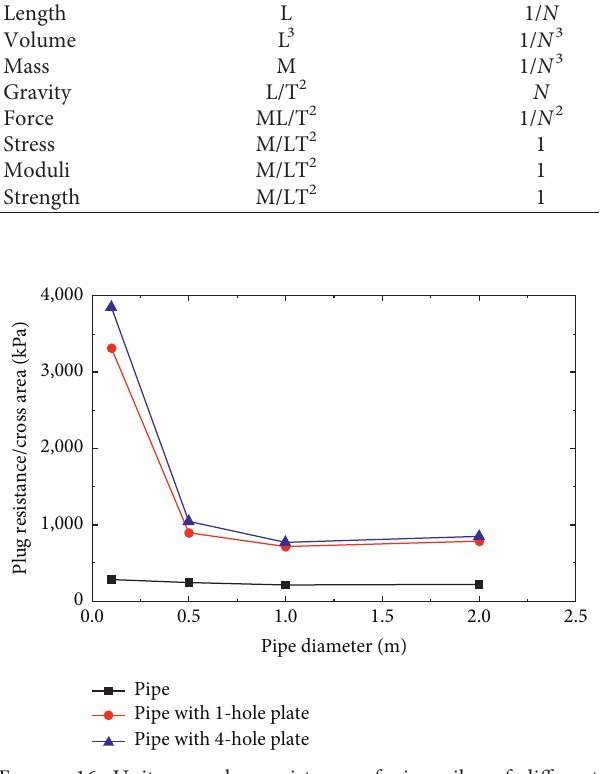
Figure 16: Unit area plug resistance of pipe piles of different diameters with/without restriction plates from geotechnical cen- trifuge simulations ( L / D �